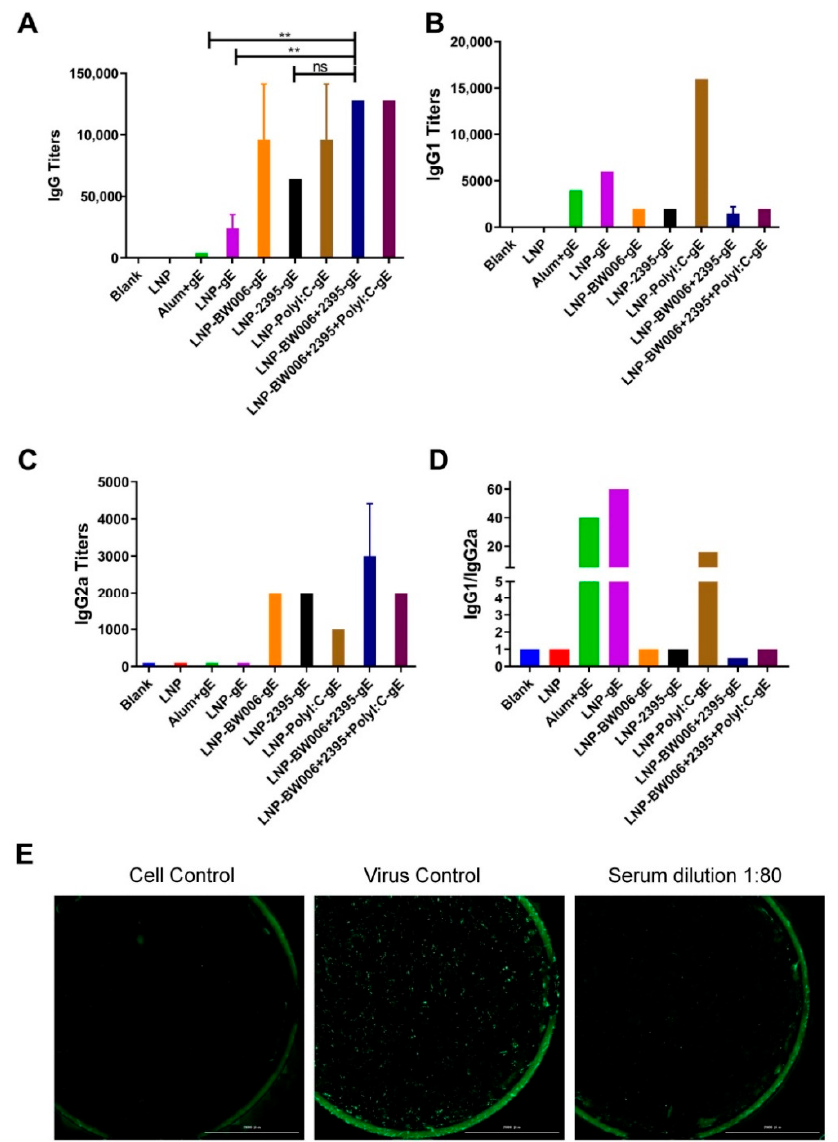
Figure 2. Humoral immune responses. ( A ) gE-specific IgG titers; ( B ) gE-specific IgG1 titers; ( C ) gE- specific IgG2a titers; ( D ) IgG1/IgG2a ratios; ( E ) Neutralizing effects of serum from LNP-BW006+2395- gE-immunized mice. Scale bar, 2000 µ m. ** p < 0.01. ns, no significant difference.